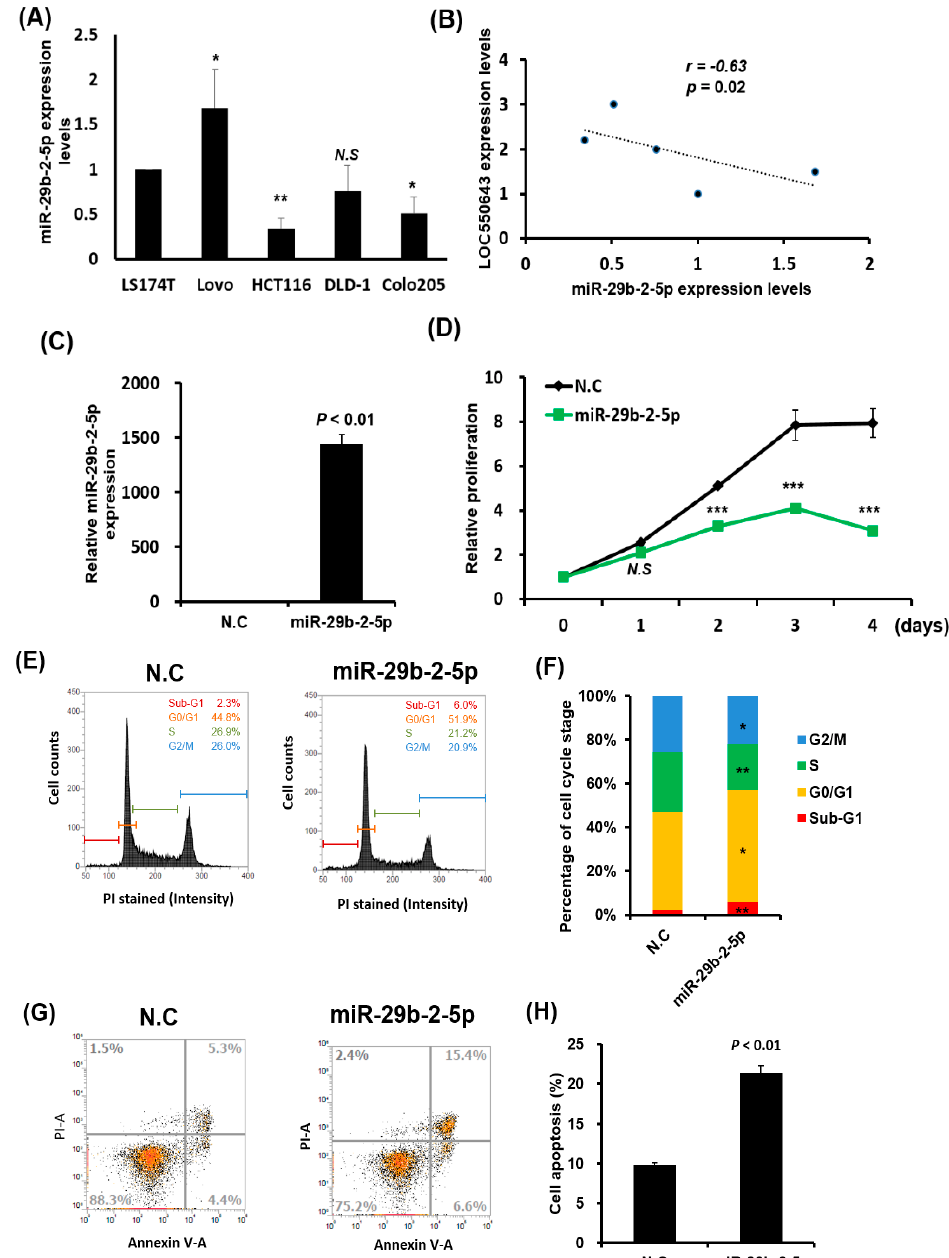
Figure 8. MiR-29b-2-5p overexpression hindered cell cycle progression and induced apoptosis in colon cancer cells. ( A ) The expression levels of miR-29b-2-5p were assessed in human colon cancer cells. ( B ) The correlation between miR-29b-2-5p and LOC550643 were analyzed through Pearson correlation analysis. ( C ) The expression levels of miR-29b-2-5p were examined in HCT116 cells transfected with miR-29b-2-5p mimics over 48 h. ( D ) Cell proliferation was assessed in HCT116 cells transfected with miR-29b-2-5p mimics. ( E , F ) The cells in each phase of the cell cycle were analyzed through flow cytometry, and the population of cells in each phase was quantified using NucleoView NC-3000 software. ( G ) Cell apoptosis was detected through the annexin V assay, and ( H ) the population of apoptotic cells in HCT116 cells with miR-29b-2-5p mimic transection and in control cells were quantified (* p < 0.05, ** p < 0.01, *** p < 0.001).